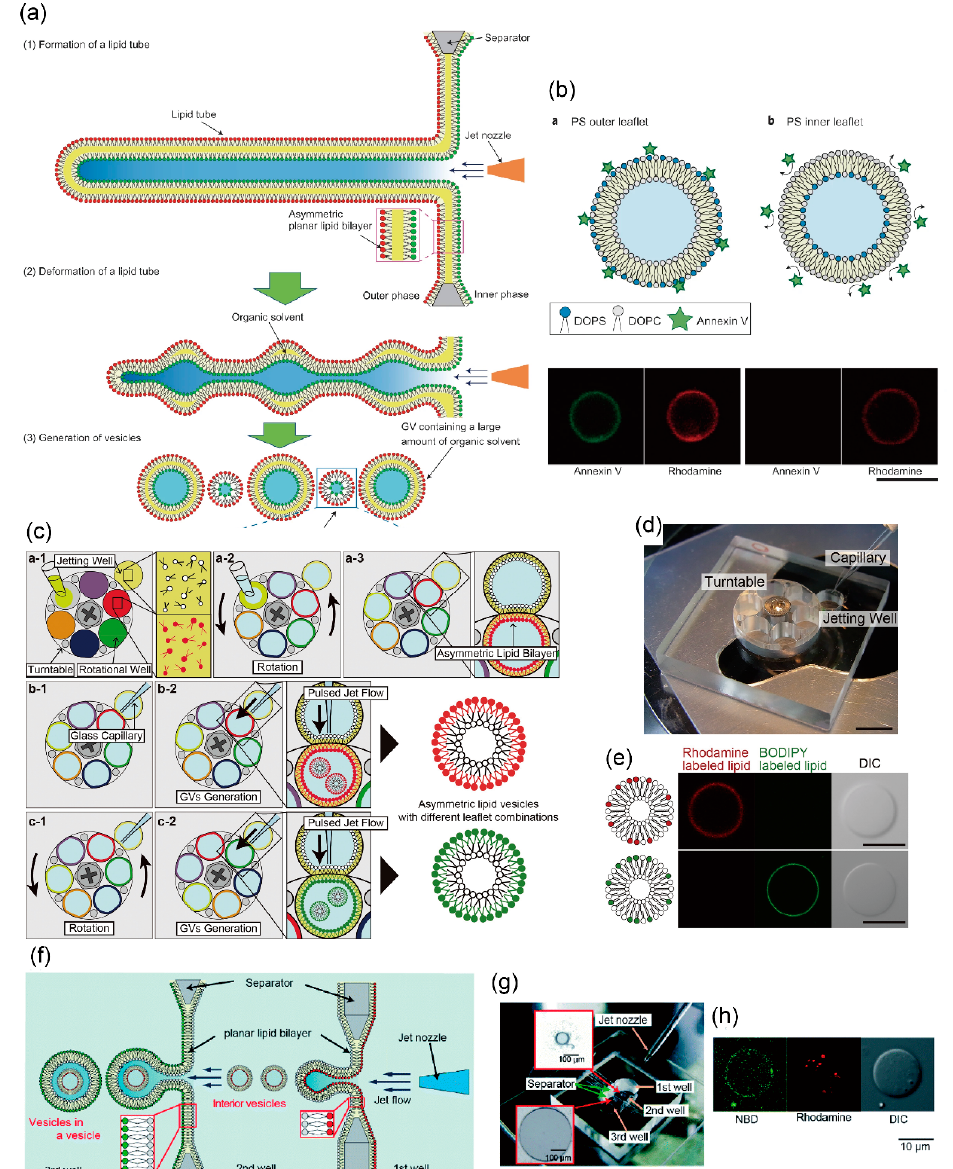
Figure 2. ( a ) Cell-sized asymmetric lipid vesicles from a planar asymmetric lipid bilayer using the pulsed-jet flow; ( b ) asymmetric lipid vesicles with DOPS on the outer leaflet or the inner leaflet. The green fluorescence represents annexinV and the red fluorescence represents the lipid membrane (rhodamine). (( a , b ) are reproduced with permission from [87].). ( c ) Schematic images of a sequential giant lipid vesicle generation method with various lipid combinations using a rotational well device; ( d ) image of the fabricated device for generating sequential cell-sized asymmetric lipid vesicles. The device consists of a turntable with six wells and a base with one jetting well; ( e ) typical confocal images of cell-sized asymmetric lipid vesicles with rhodamine or BODIPY-conjugated lipid on the outer leaflet using the rotational well device. (( c – e ) are reproduced with permission from [88].). ( f ) Schematic illustration of vesicles-in-a-vesicle generation using pulsed-jet flow method. ( g ) Image of a triple-well device for generating vesicles-in-a-vesicle; ( h ) typical confocal images of vesicles-in-a-vesicle using the triple-well device. Small vesicles with rhodamine-conjugated lipids were encapsulated into giant vesicles with NBD-conjugated lipids. (( f – h ) are reproduced with permission from [90].).